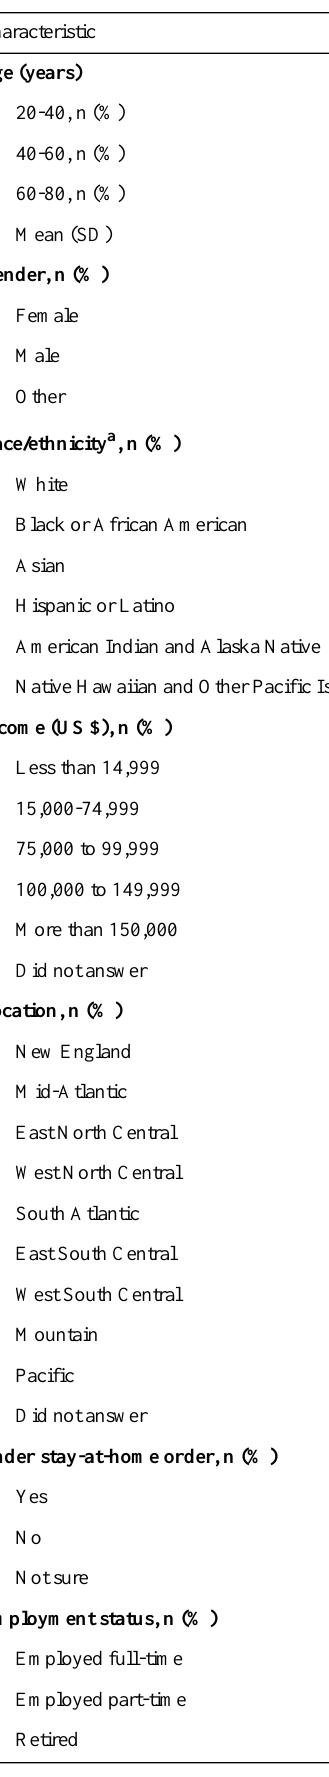
Table 1. Demographic and descriptive statistics of the study participants